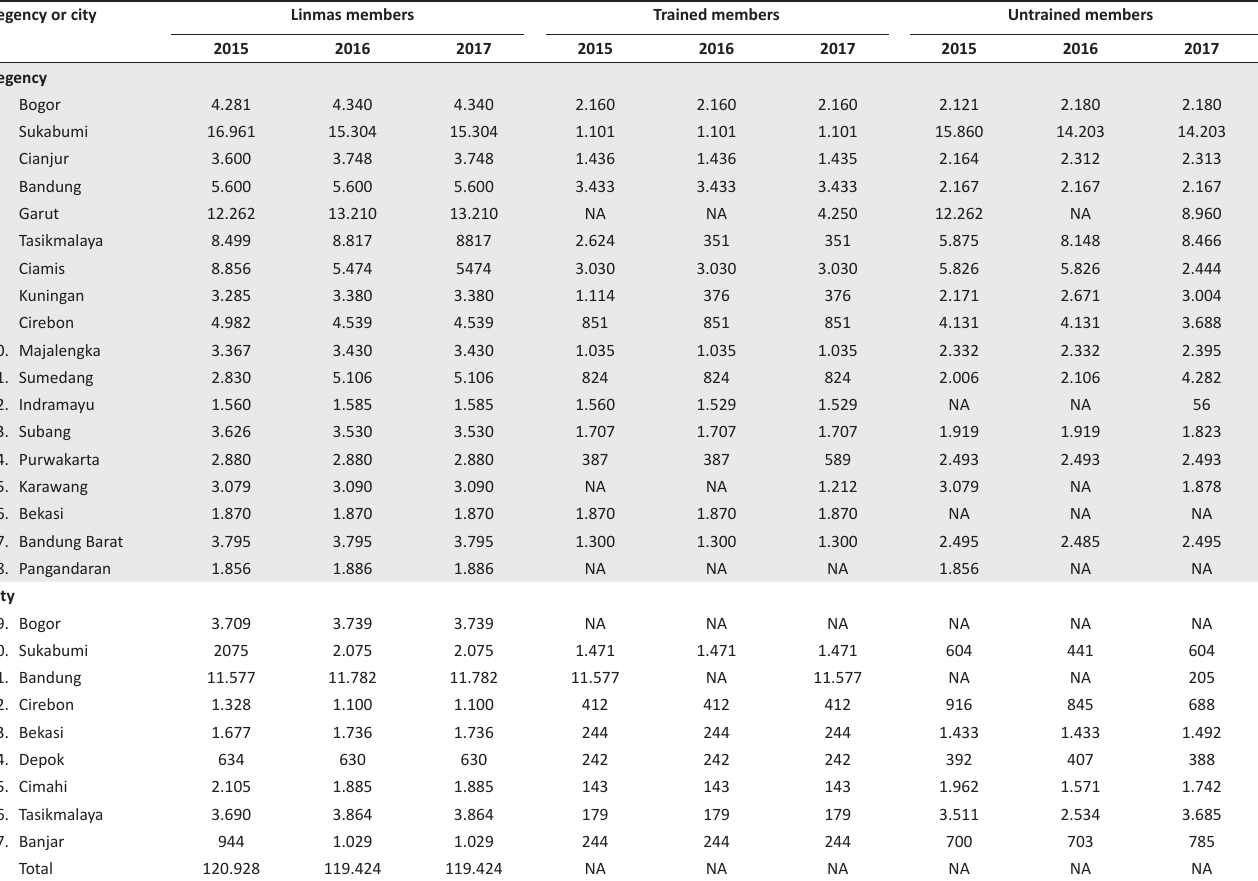
TABLE 4 : Members Linmas and trained members by regency or city in west Java Province, 2015‒2017. Regency or city Linmas members Trained members Untrained